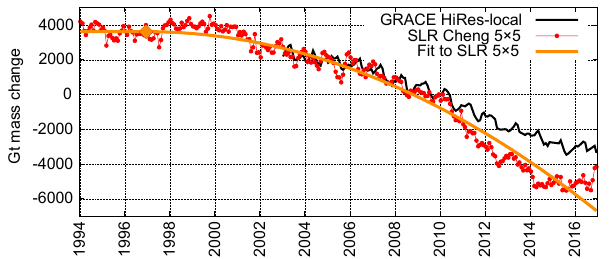
Figure 4. Mass loss over Greenland and Antarctica combined, car- ried back to 1994, from the Cheng 5 × 5 SLR inversion. Monthly results are shown as red dots with the best-fit accelerating curve sketched in orange. The orange diamond represents the point at which acceleration begins. The high-resolution, local GRACE in- version beginning in 2003 is shown (black) for comparison.